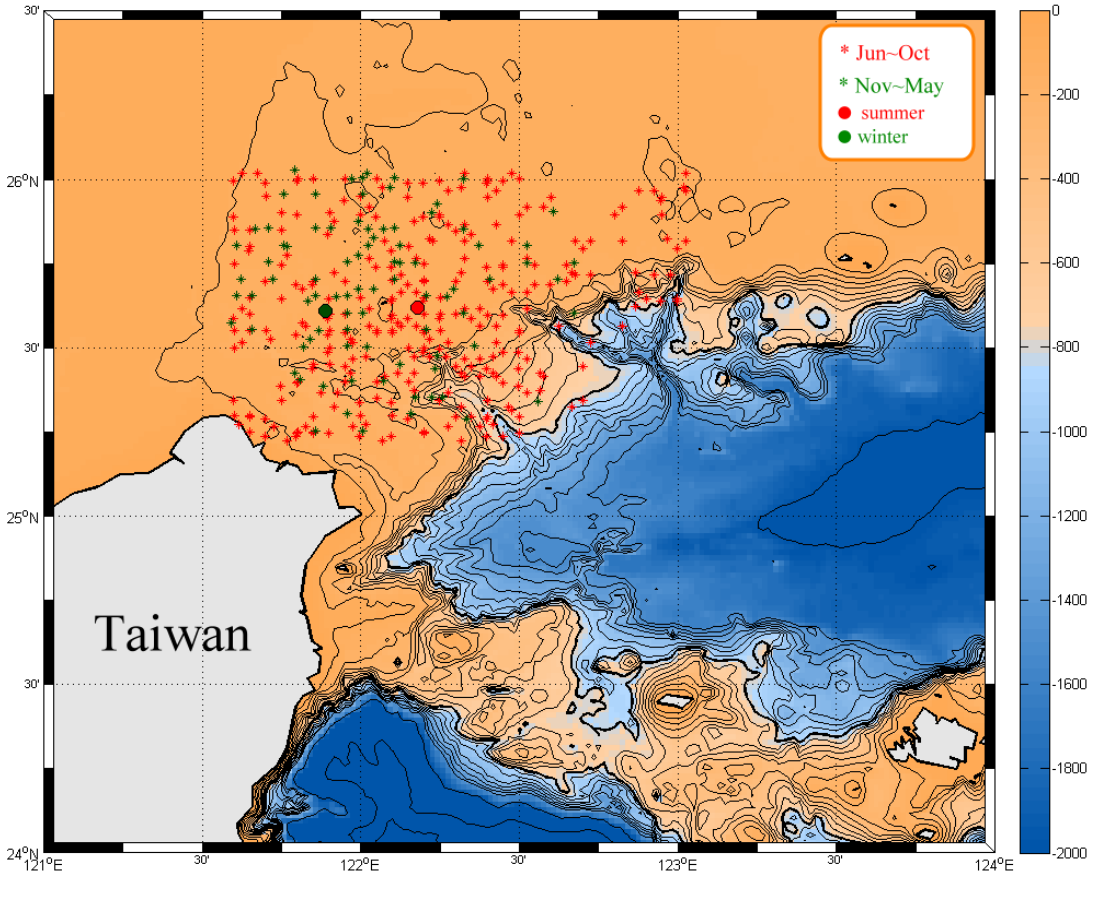
Figure 7. Distribution of the centroid of cold patch. Red stars denote the distribution of cold patch in summer (June to October) and green stars show the distribution of cold patch in winter and transaction periods (November to May). Red and green dots are the mean positions of distribution in summer and winter, respectively. The bathymetry is shown with contours in